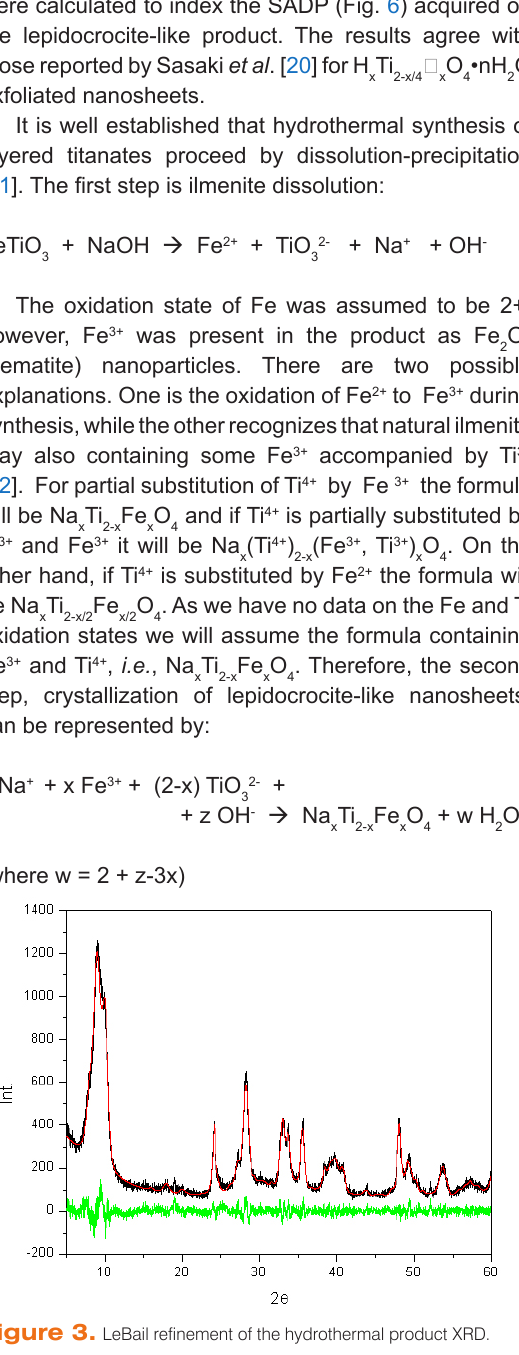
image (b), and (c) HREM image of a nanosheet cross section (beam perpendicular to